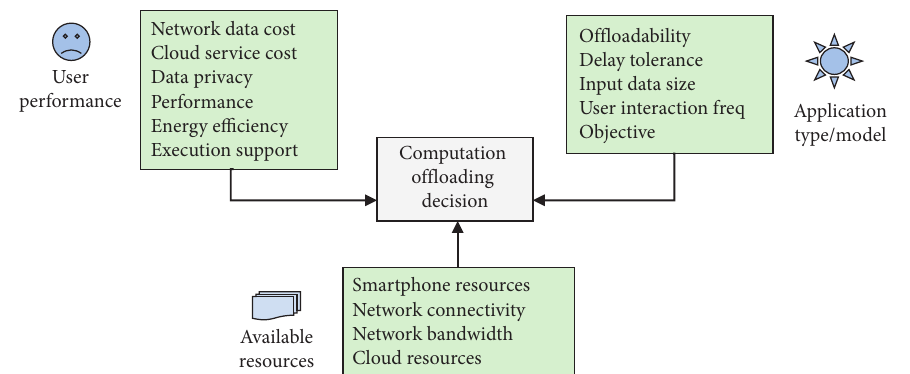
Figure 5: Factors affecting computation offloading decision [33]. Table 2: Summary of energy-aware techniques in